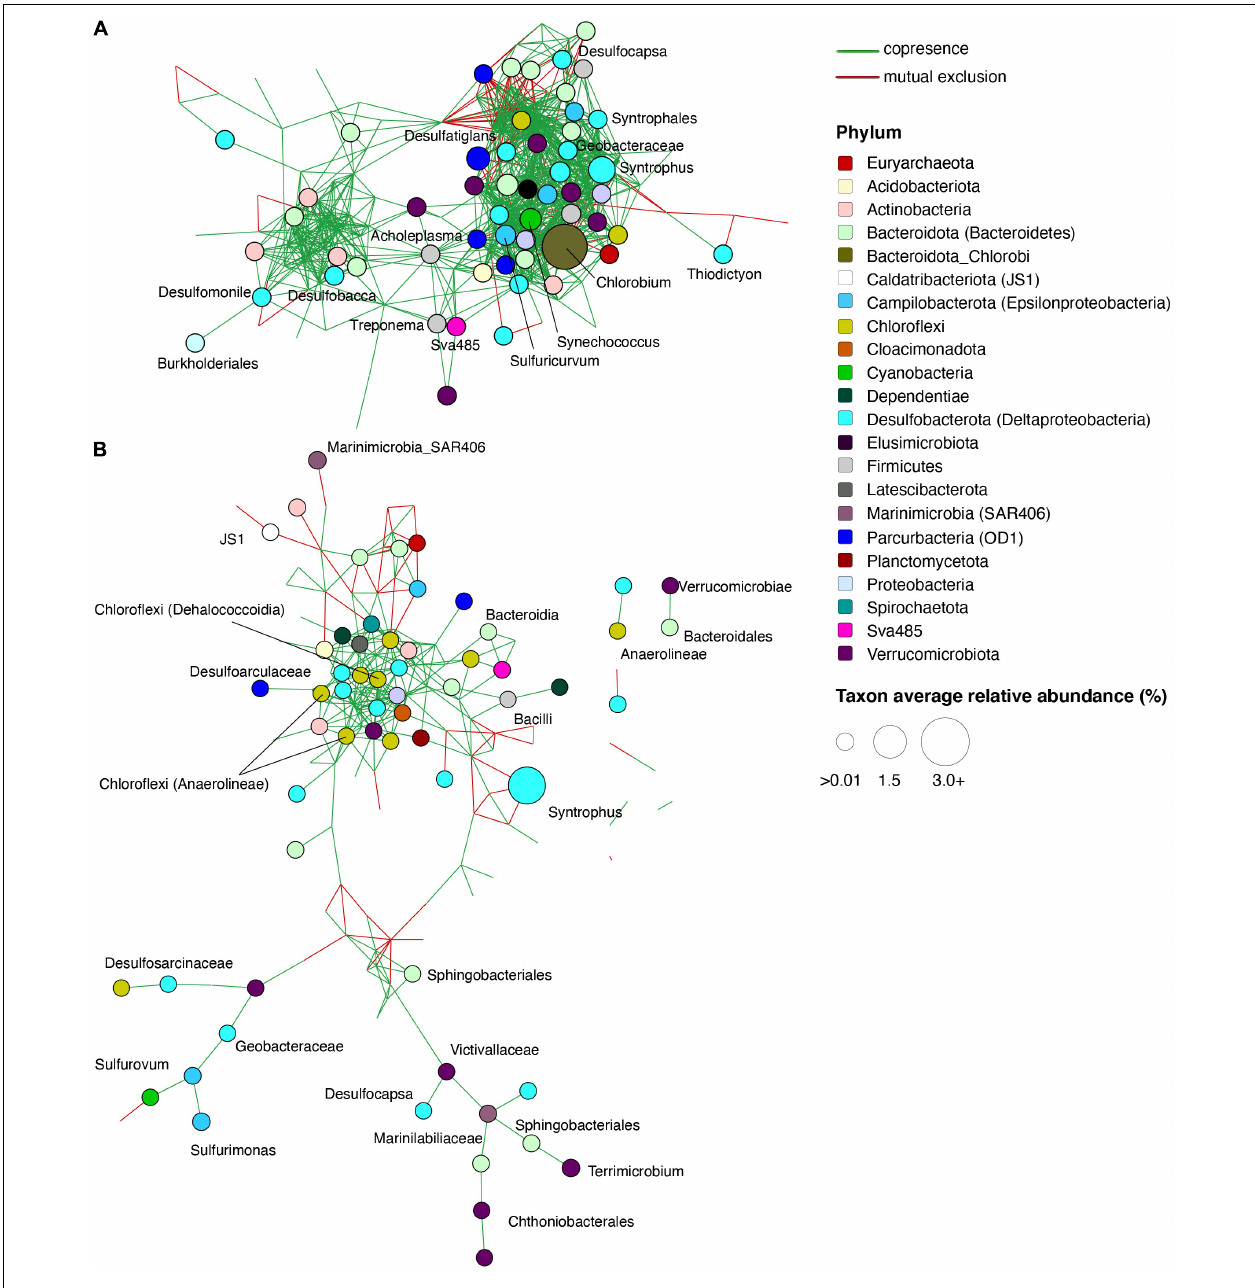
FIGURE 6 | Significant co-occurrence and co-exclusion relationships among bacterial taxa in the FGL water column. Networks of microbial communities from the (A) Upper monimolimnion (21 and 24 m) and (B) Lower monimolimnion (30, 45, and 52.5 m). Networks were built from 16S rRNA gene profiles using CoNet in Cytoscape. Nodes represent taxa (genus level), are colored by phylum, and their size is proportional to the relative abundance of the taxon. Each edge represents a significant co-occurrence/mutual exclusion relationship ( p < 0.05; green, co-occurrence; red,